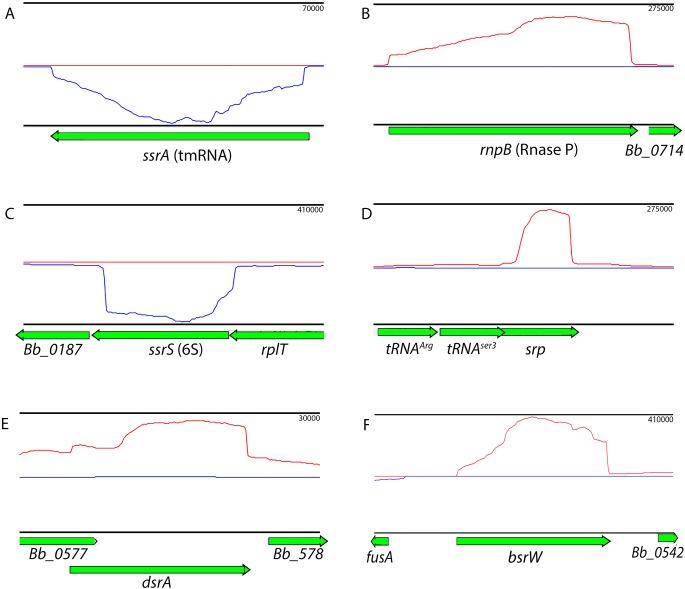
Examples of intergenic noncoding RNAs.Red lines indicate transcript abundance from the + strand (left to right) and blue indicate transcript abundance from the–strand (right to left), and are shown above (+) and below (-) the central axis. Genes are noted below coverage plots and directionality is given by arrows at the ends of genes. Relative orientation of genes on the X axis is consistent with RefSeq annotations. Coverage per base is given on the Y axis to the left of the plot. Neither dsrA (E) nor 6S (C) are currently annotated in either GenBank or RFAM. dsrA is shown as the longest possible transcript described in [42].